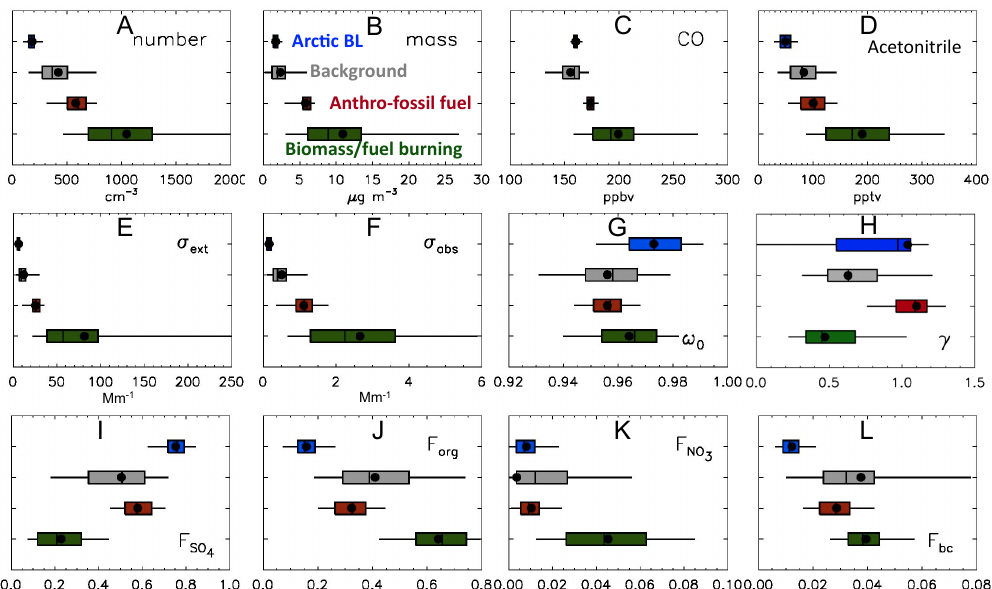
Fig. 6. Statistics of occurrence for parameters separated by airmass classification. Each box encloses the interquartile range and the whiskers the 5th and 95th percentiles. The vertical bar and symbol are the median and arithmetic mean, respectively. ( (A) submicron aerosol number concentration, (B) submicron non-refractory aerosol mass concentration, (C) CO mixing ratio, (D) acetonitrile mixing (AN) ratio, (E) fine aerosol extinction at 532nm ( σ ext ) , (F) fine aerosol absorption at 530nm ( σ abs ) , (G) fine aerosol single scattering albedo ω o , H) hygroscopicity parameter γ (Eq. 1), (I) fraction of fine mass that is SO = (F SO4 ) , (J) fraction of fine mass that is organic (F org ) , (K) fraction 4 of fine mass that is NO − (F NO3 ) , and (L) fraction of fine mass that is BC (F BC ) . All extensive aerosol parameters, including σ ext and σ abs , 3 are at STP (1013hPa, 273.15K) conditions at a measurement RH of < 10%. Additional statistical summaries for these and other parameters are in Table